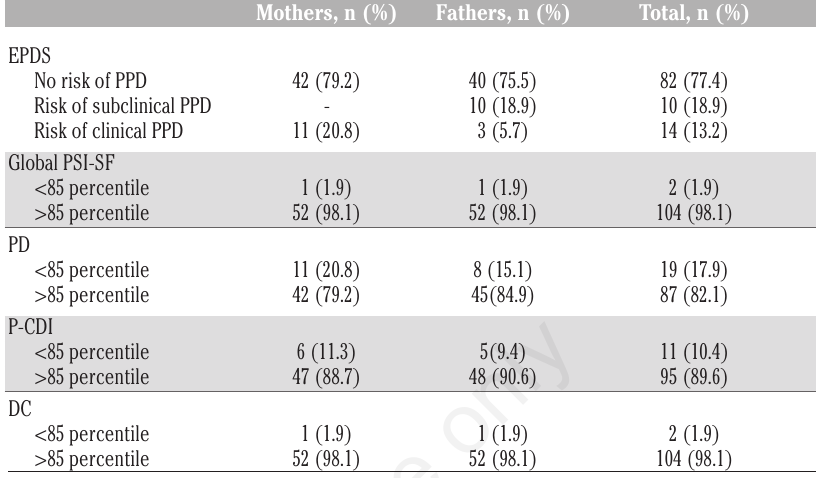
Table 1. Prevalence of postpartum depression risk and parenting distress levels (N=53 couples; N=106